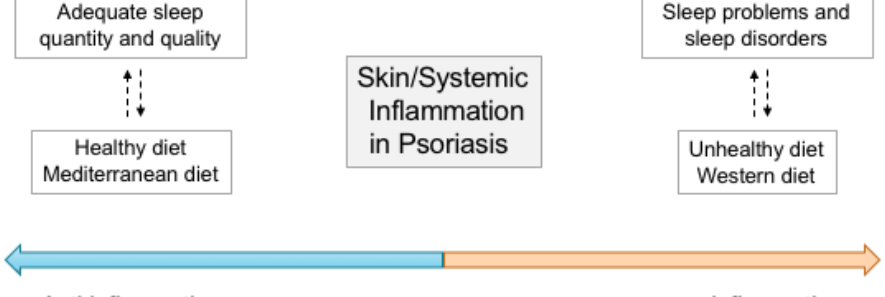
Figure 1. Psoriasis is associated with sleep disorders and unhealthy dietary patterns through the activation and/or regulation of systemic and skin inflammation. On the left, the scheme shows protective effects obtainable via adequate sleep quantity and quality together with healthy diet on psoriasis disease.